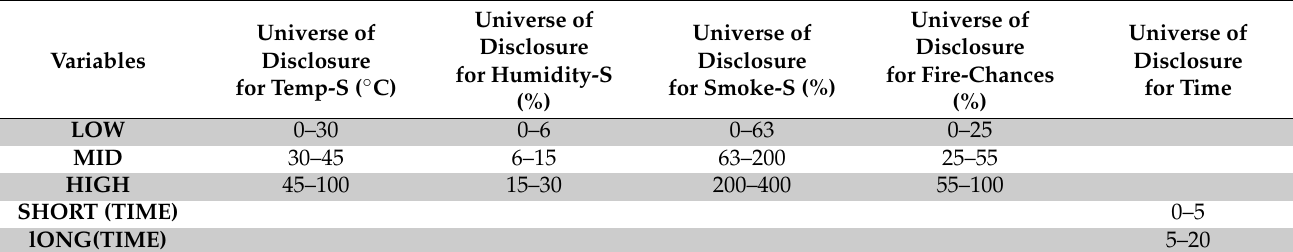
Table 4. Experiment No. 3.